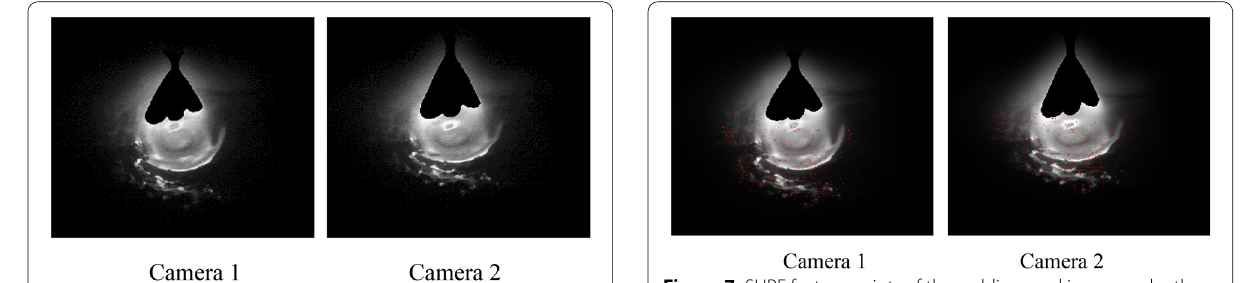
Figure 6 Pre-processed images of the welding pool under the arc (240 A, 33 V, 0.6 m/min)